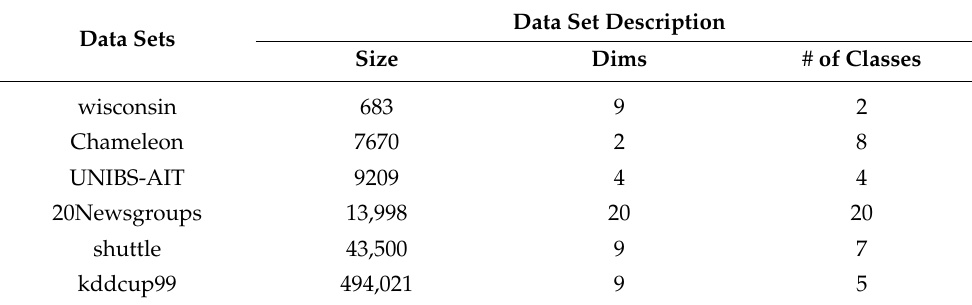
Table 2. Description of the benchmark data sets. Data